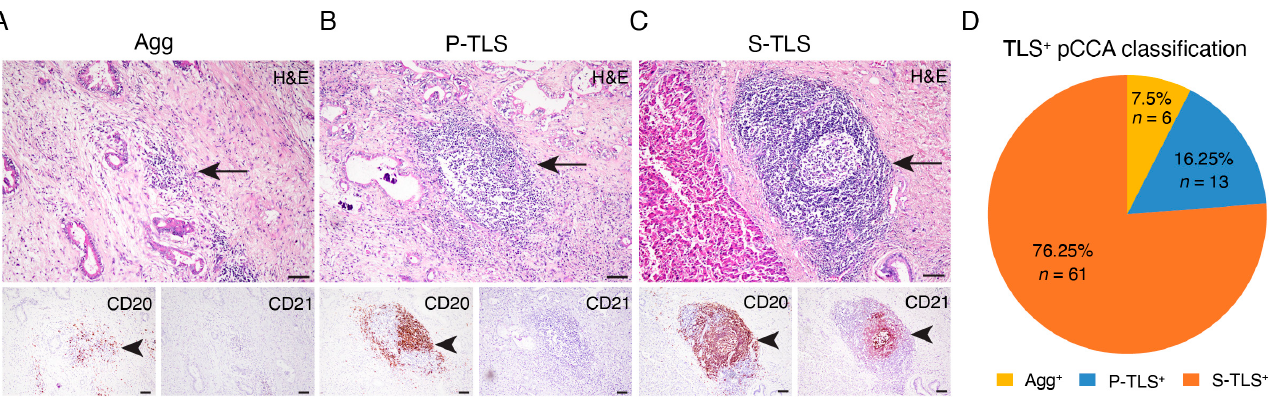
Figure 1. Classification of TLS and TLS-positive patients with pCCA. ( A – C ) Representative images of lymphoid aggregates (Agg, left panel), primary follicle-like TLS (P-TLS, middle panel), and secondary follicle-like TLS (S-TLS, right panel) in human pCCA specimens as assessed using IHC staining for CD20 and CD21 and H&E staining. ( D ) Pie charts indicating the TLS composition of patients with pCCA. Scale bar in ( A – C ) represents 200 µ m. The black arrowheads indicating TLSs in the below IHC staining image of CD20 and CD21 match the black arrows in the continuous section H&E staining image above.